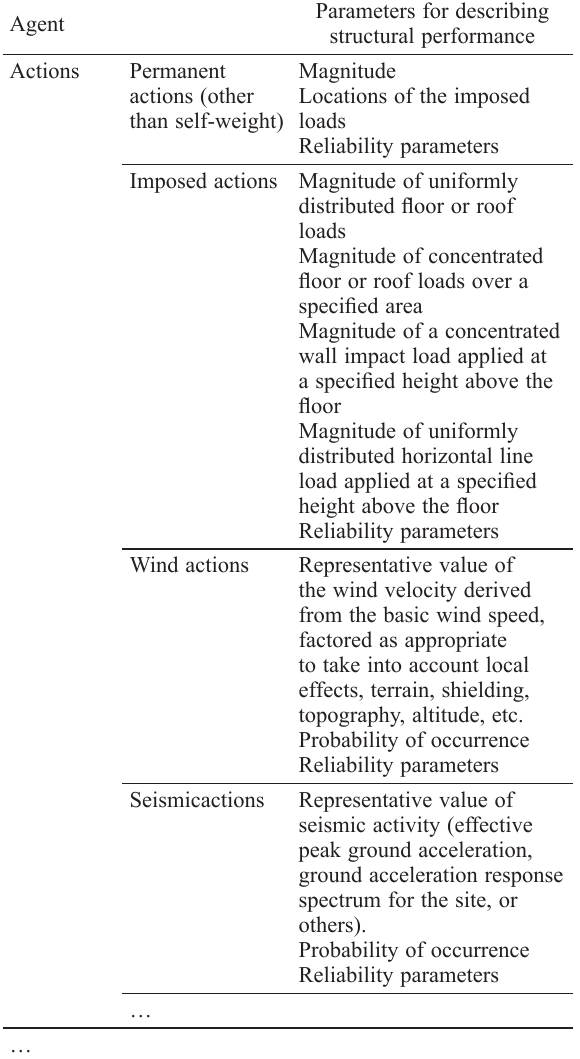
Table 3. Example of metrics for evaluating structural safety Agent